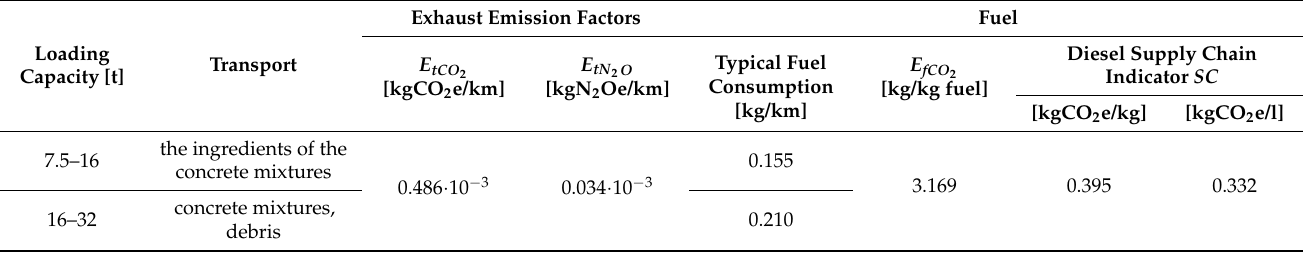
Table 4. Data used to calculate transportation emissions. Own elaboration based on [65].